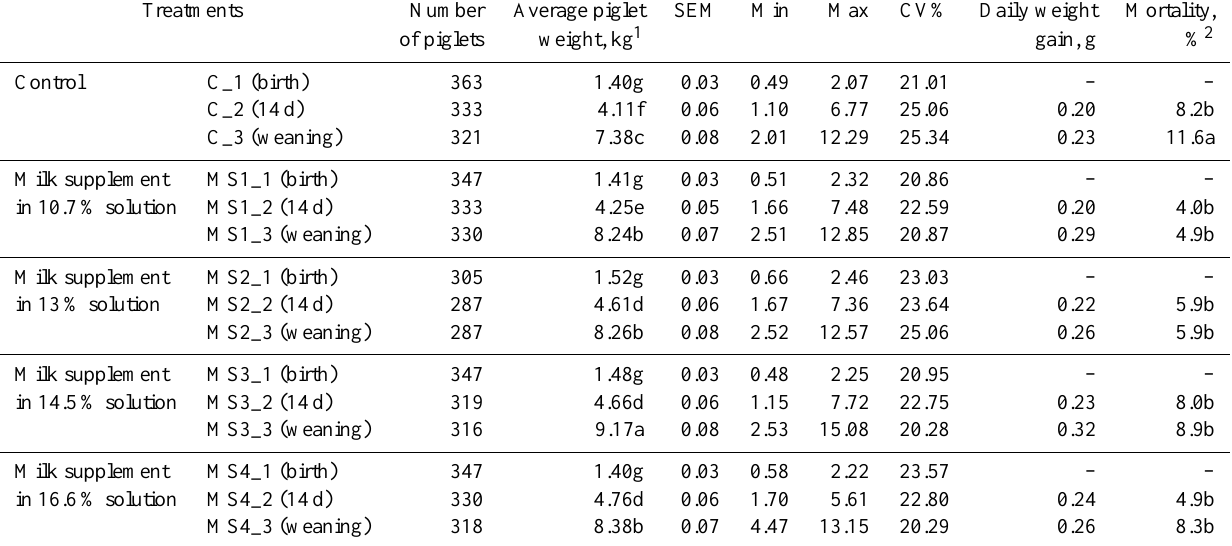
Table 3. The results of the repeated measure mixed effect model.